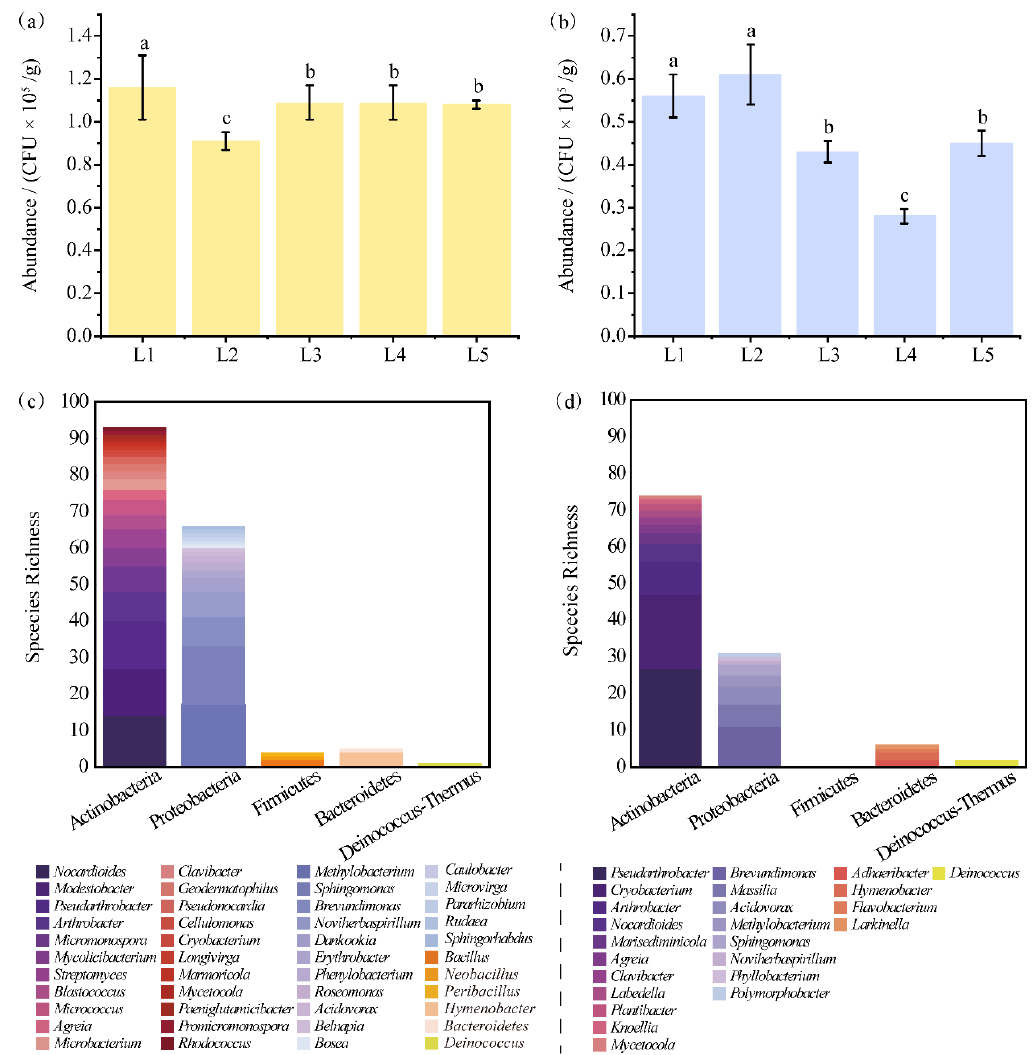
Figure 3. Abundance and species richness of bacteria in the glacier snout of Laohugou Glacier No. 12. Abundance of bacteria at different sites at HT ( a ) and LT ( b ). Species richness of bacteria at HT ( c ) and LT ( d ). Error bars in ( a ) and ( b ) represent the standard error of three samples collected from each site. Different letters over the bars in ( a ) and ( b ) indicate significant differences in CFUs at different sites. The Y-axis in ( c ) and ( d ) represents the number of species.